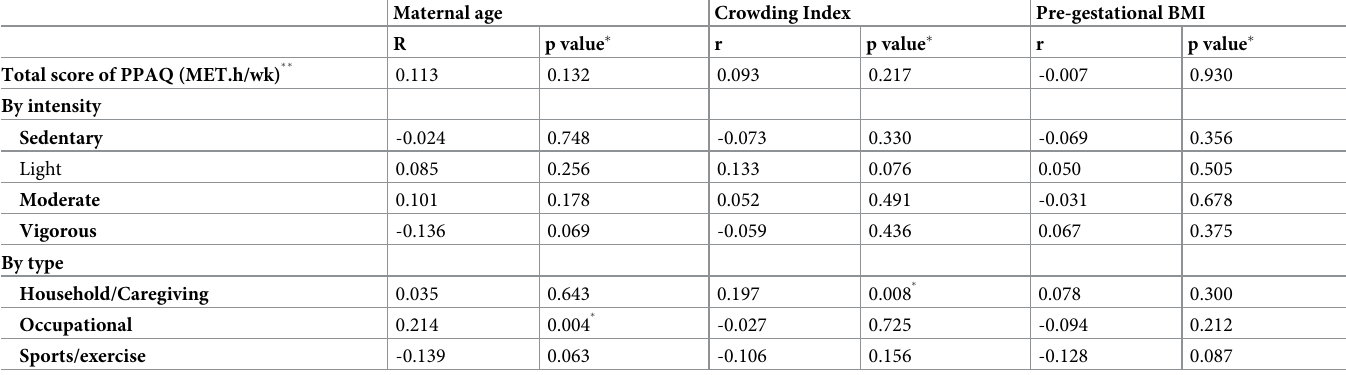
Table 6. Correlations between the type and the intensity of physical activity, deducted from the PPAQ, in women with maternal age, crowding index and pre-gesta- tional BMI (N = 179).